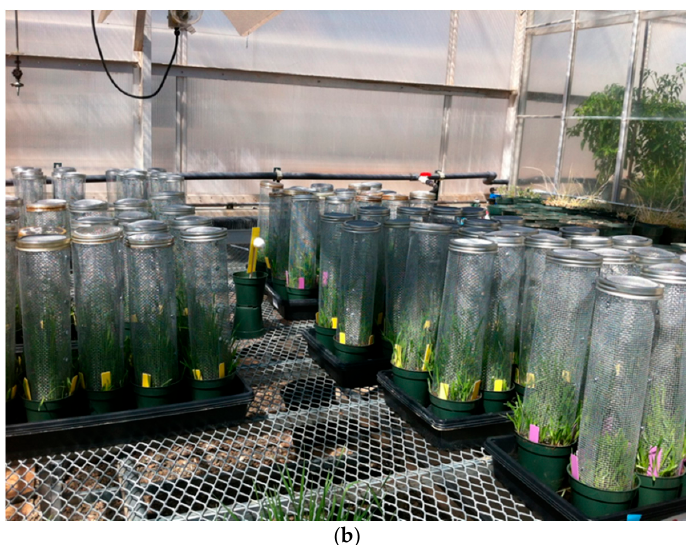
Figure 1. Plastic cage ® covered with window screens mesh in the laboratory ( a ); cylindrical metal hardware cloth cages over the sprouted wheat in the greenhouse ( b ).